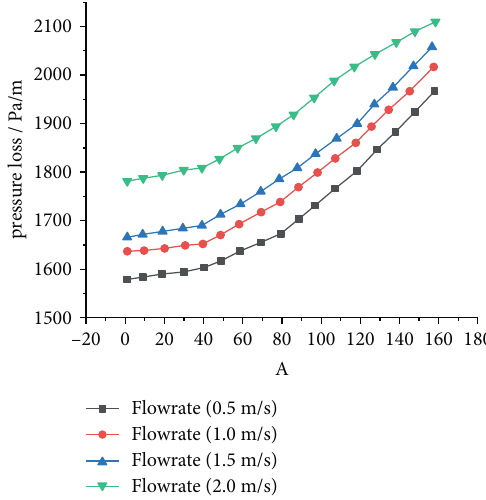
Figure 6: E ff ect of rotation on the pressure loss with various fl